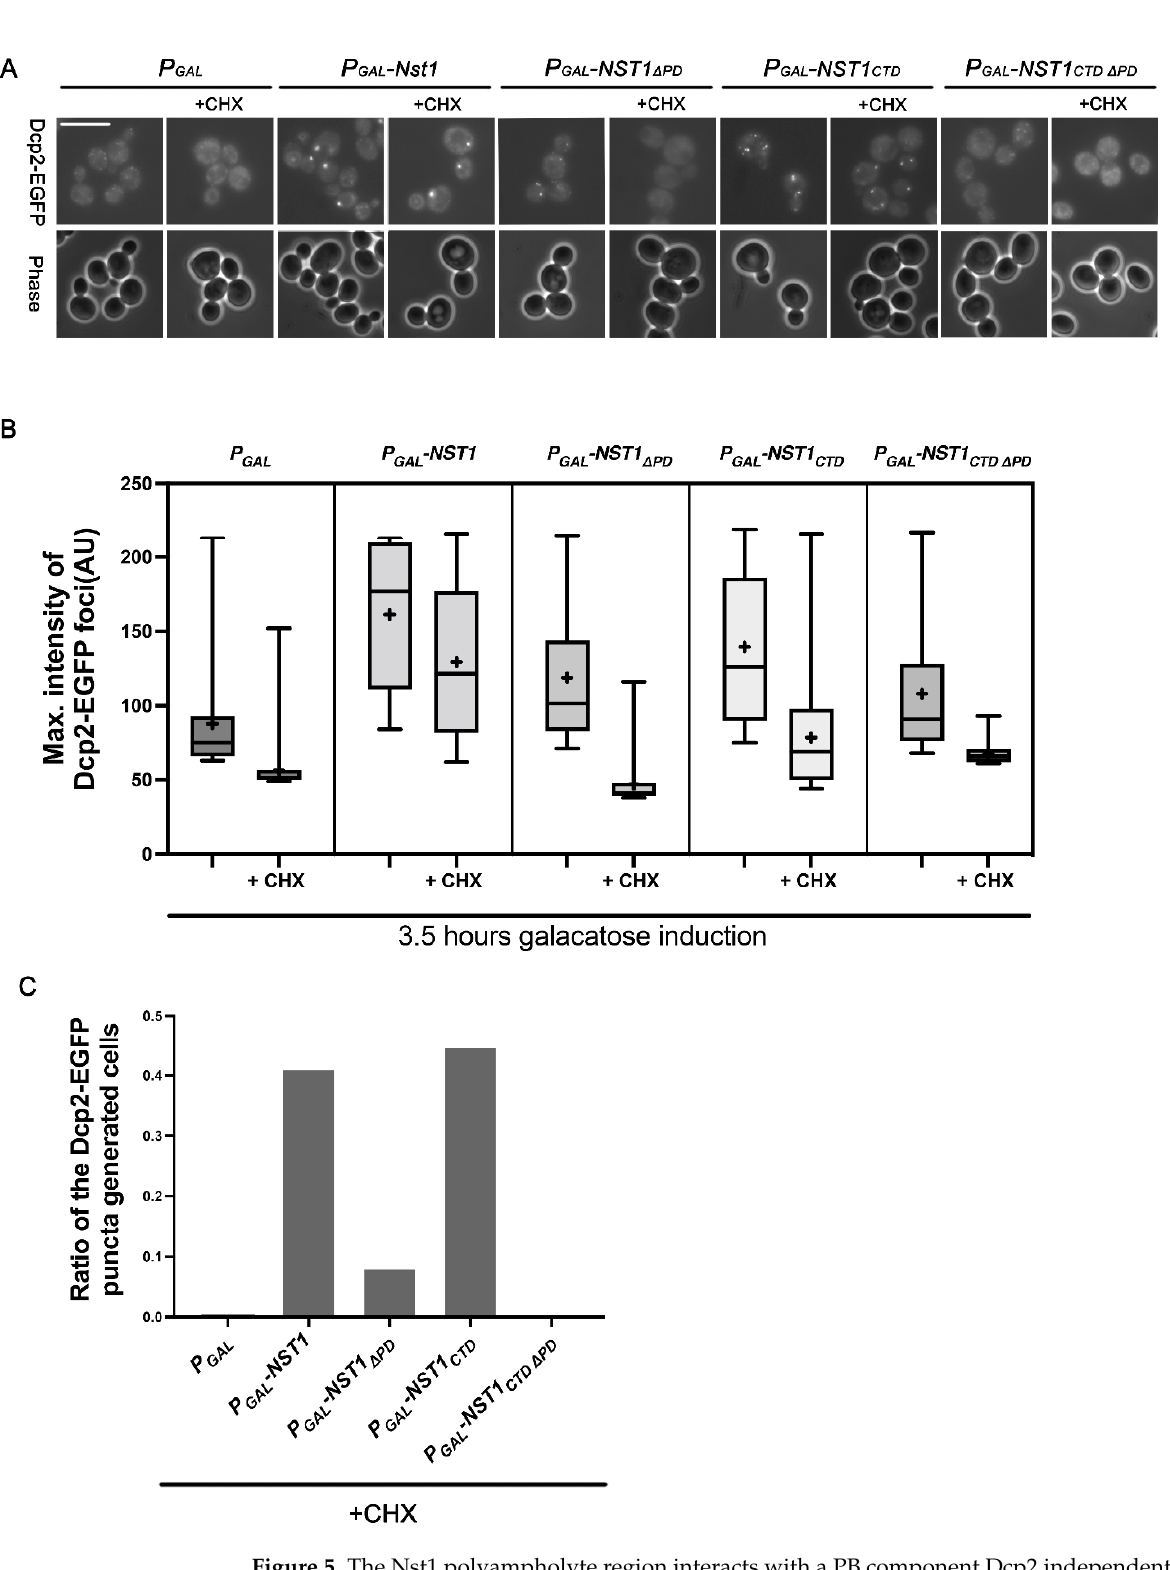
Figure 5. The Nst1 polyampholyte region interacts with a PB component Dcp2 independent of the free ribosomal RNA influx. ( A – C ) In the wild-type strain whose chromosomal DCP2 was tagged with EGFP , endogenous EGFP-Dcp2 was observed after the overexpression of full-length Nst1, Nst1 Δ PD (residues 1–630 and 753–1240), Nst1 CTD (C-terminal Nst1 residues 430–1240), and Nst1 CTD Δ PD (residues 431–630 and 753–1240). In the cells overexpressing each Nst1 domain deletion mutant, endogenous Dcp2 was observed before and after the 10 min 100 μ g/mL cycloheximdie (CHX) treat- ment . ( A ) Fluorescence microscopy of EGFP-Dcp2 in the cells overexpressing each mutant before